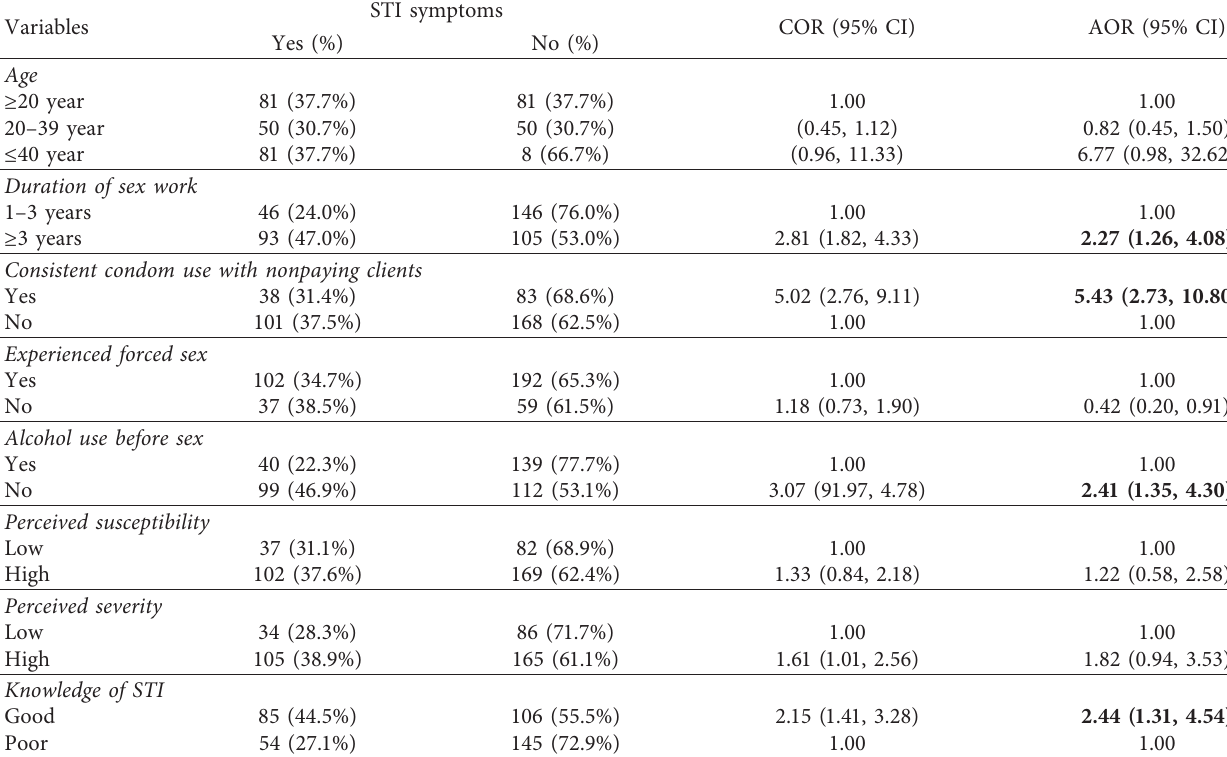
Table 3: Factors associated with self-reported STI symptoms among FSWs working in licensed drinking establishments of Adama Town, Oromia regional state, Ethiopia, March 2017 ( N � 390).